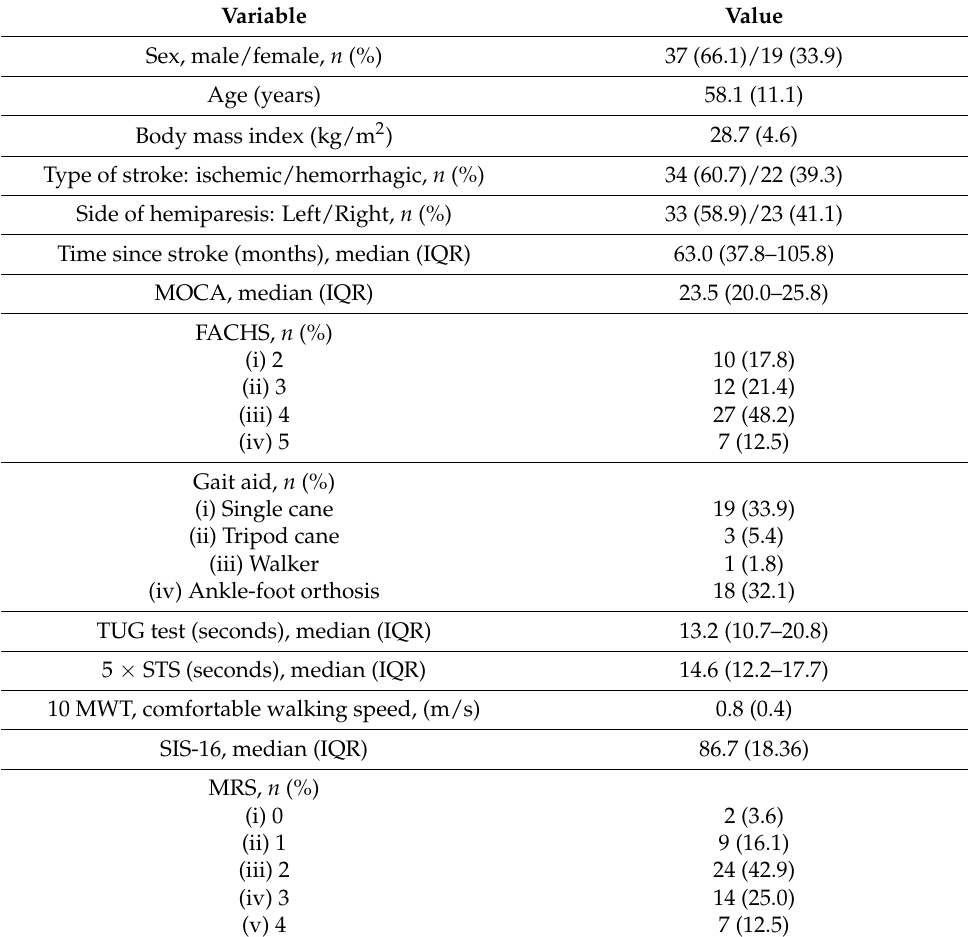
Table 2. Participants’ demographic and clinical characteristics ( n = 56).